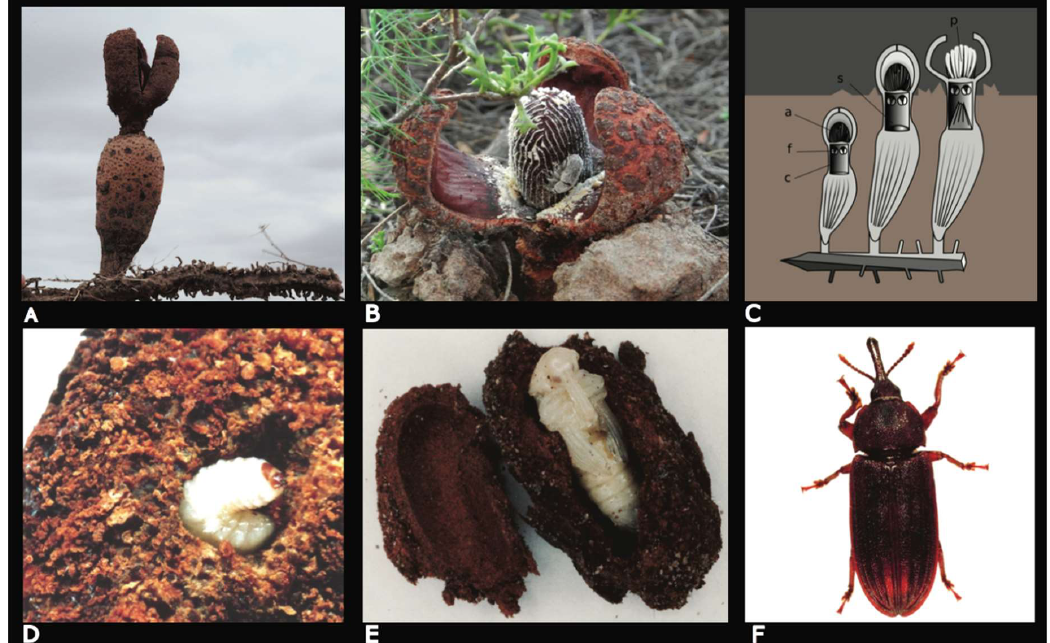
Figure 1. The plant Prosopanche americana ( A – C ) and its associated weevil Hydnorobius hydnorae ( D – E ). ( A ) Flower showing the open perianth and perigonial tube on top of the inferior ovary attached to a rhizome bearing haustorial roots; ( B ) Open flower showing the dome-like androecium releasing pollen and bearing a pair of mating H. hydnorae ; ( C ) Development of the Prosopanche flower from bud (left) to open flower in stigmatic (middle) and staminal (right) phases (a, anther body; f, fenestrae connecting a and c; c, stigmatic chamber; s, receptive stigma; p, pollen); ( D ) H. hydnorae full-grown larva in decaying plant tissue; ( E ) H. hydnorae pupa in pupal cell and ( F ) Dorsal view of adult H. hydnorae .